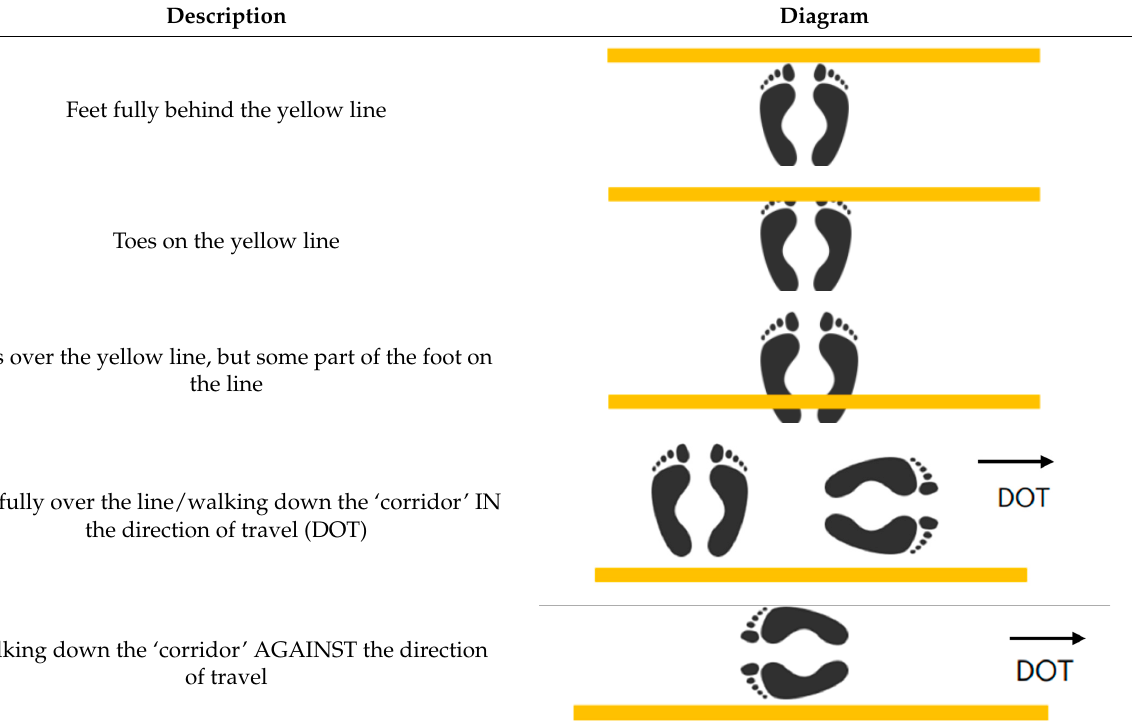
Table 1. Experimental evaluation method to detect when passengers were respecting the yellow safety line considering the direction of travel (DOT), adapted from [16].